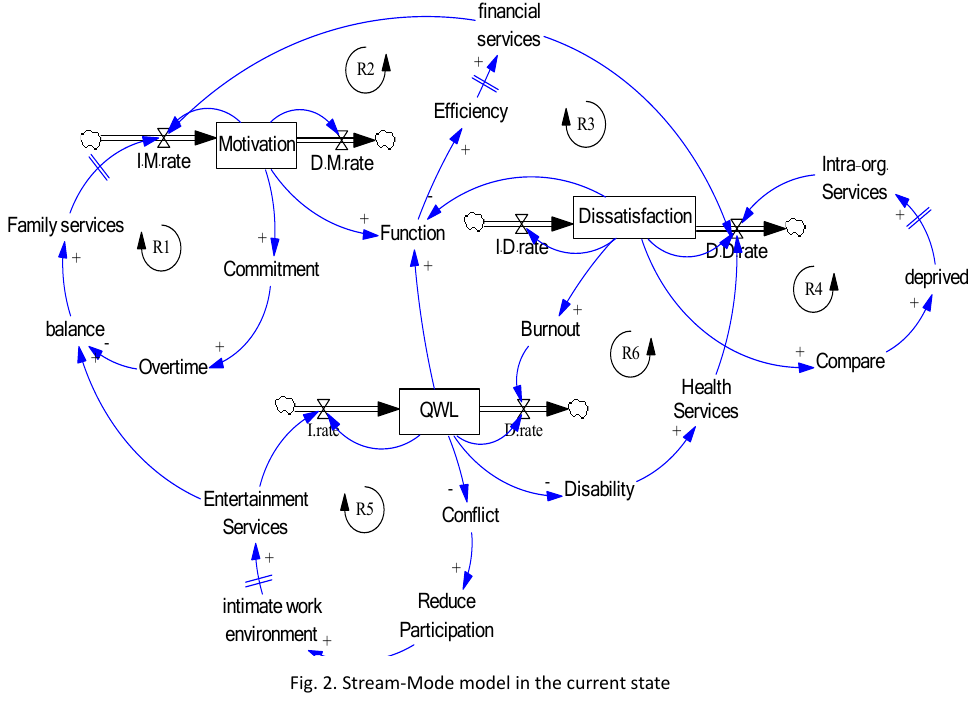
Fig. 2. Stream-Mode model in the current state Fig. 2: Stream-Mode model in the current state